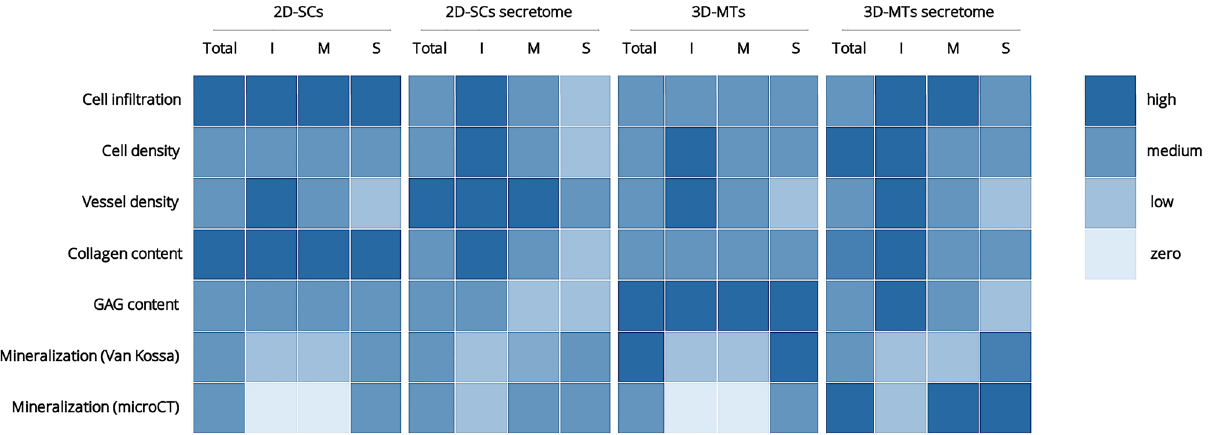
Figure 6. Heat map showing overview of key results . All quantitative results were assigned to one of the following categories zero, low, medium and high and color-coded accordingly. The investigated scaffolds of the four experimental groups 2D-single cells (2D-SCs), 3D-microtissues (3D-MTs) and corresponding secretomes were either analyzed as an entire scaffold (Total) or one of the three regions interface (I), middle (M) and surface (S).